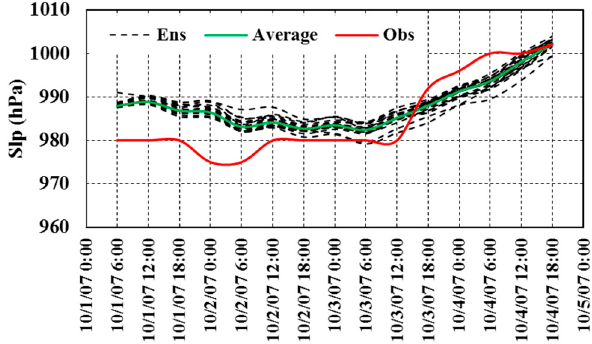
Figure 4. Estimated MSLP from nineteen ensemble members and observed MSLP from the Japan Meteorological Agency (JMA).